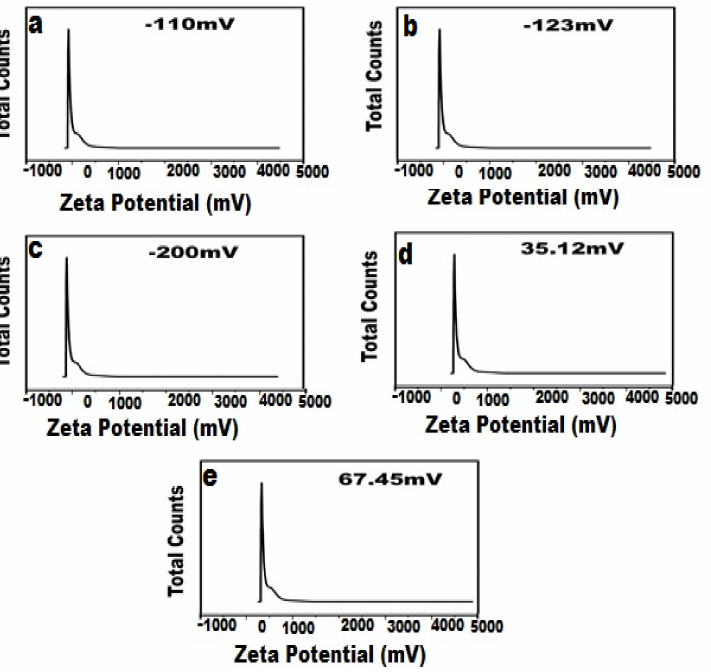
Figure 4. Zeta potential of biosynthesized nanoformulations, ( a ) TiO 2 NPs, ( b ) AgNPs, ( c ) TiO 2 /Ag nanocomposite, ( d ) CS, ( e ) CIP-TiO 2 /Ag/CS